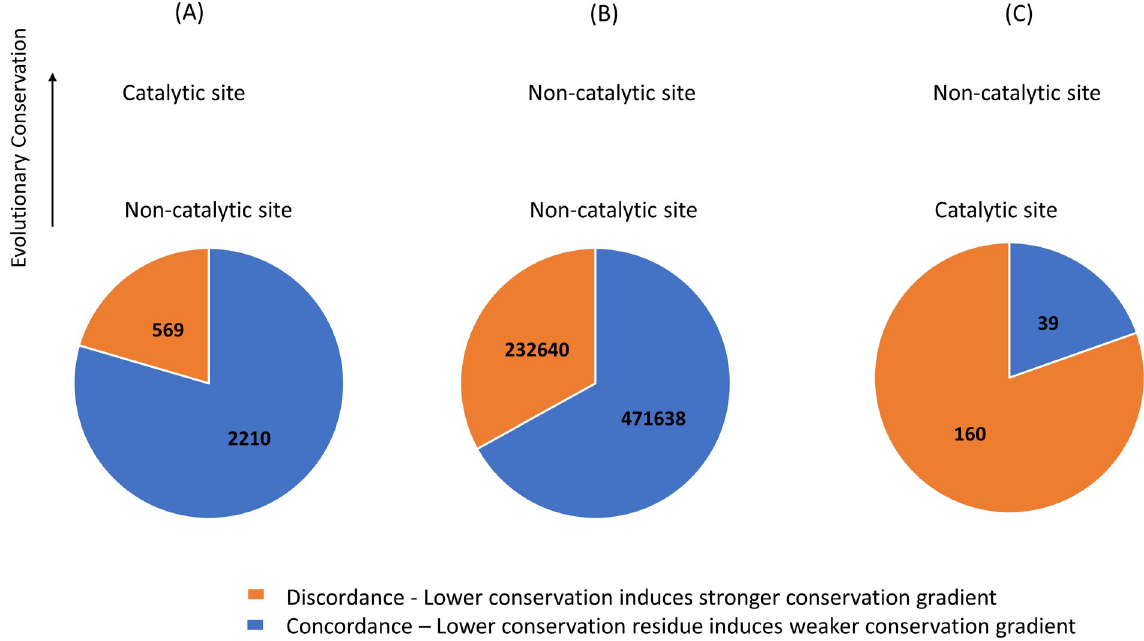
Fig 5. Catalytic site residues often induce stronger conservation gradients than more conserved non-catalytic functional site residues within the same protein. Within the same protein, (A) more conserved catalytic site residues tend to induce stronger conservation gradient than less conserved non-catalytic site residues (binomial test, P << 0.001); (B) more conserved non-catalytic site residues tend to induce stronger conservation gradient than less conserved non-catalytic site residues (binomial test, P << 0.001); (C) less conserved catalytic site residues often induce stronger conservation gradient than more conserved non-catalytic site residues (binomial test, P << 0.001). Functional site residue pairs for which the ordering of residue conservation agrees with the ordering of induced conservation gradient (concordance) are marked in blue. Functional site residue pairs for which the ordering of residue conservation disagrees with the ordering of induced conservation gradient (discordance) are marked in orange.